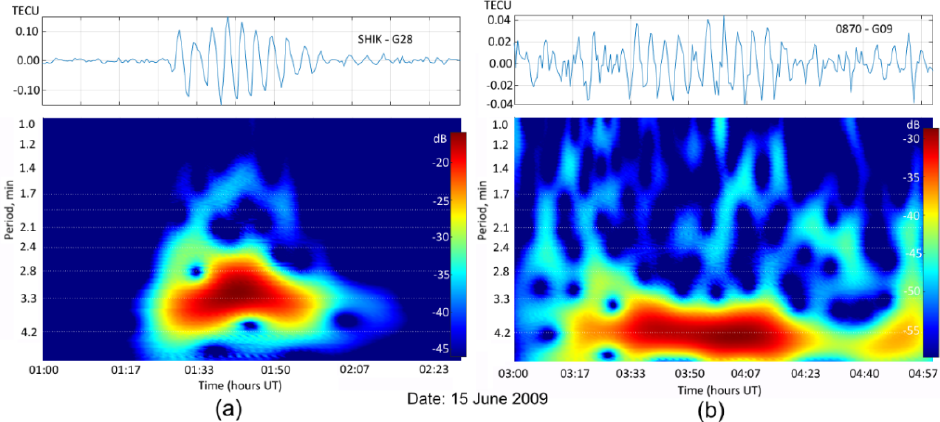
Figure 14. Examples of filtered vertical TEC series (top plots) and the corresponding spectrograms (bottom plots) ( a ) for the pair SHIK − G28 (observation site − satellite) showing the compact wave packet with relatively short oscillation period; ( b ) for the pair 0870 − G09 showing the relatively long-duration and long-period covolcanic TEC variations.